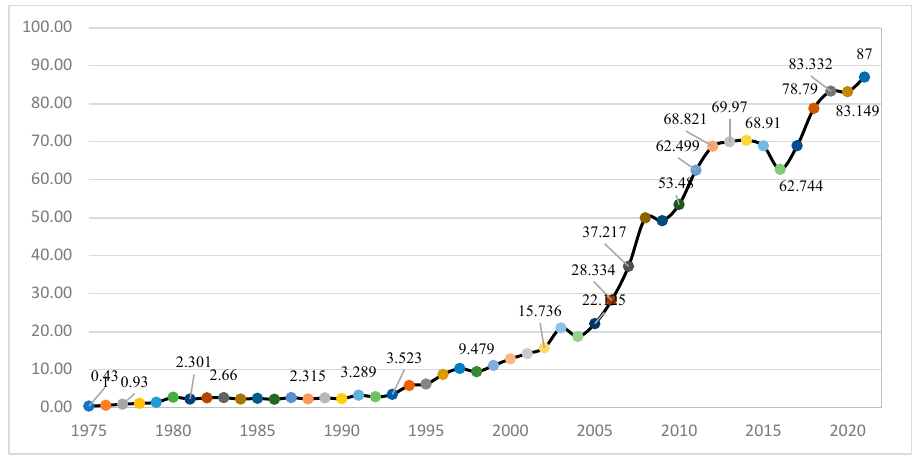
Figure 2. Remittances to India, 1975–2021. Source: [72].